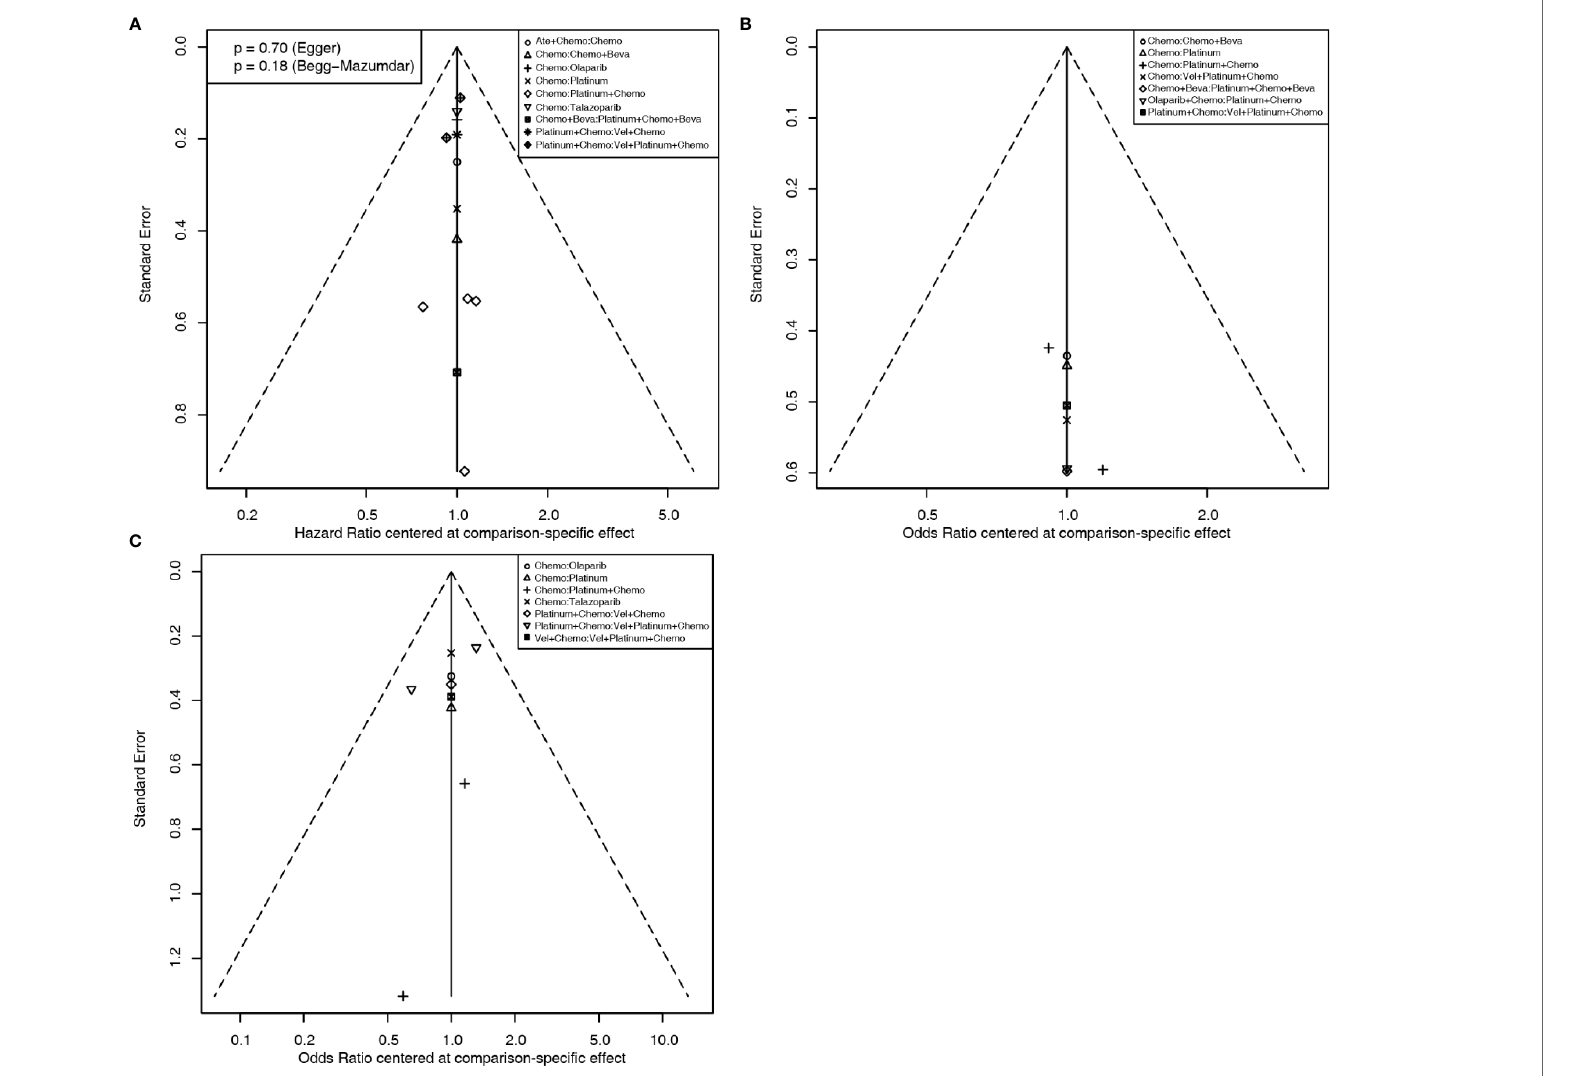
FIGURE 5 | Comparison-adjusted funnel plots for assessing PFS (A) , pCR (B) , and ORR (C) results. Potential publication bias is assessed by whether the data point distribution is symmetrical, and the Egger ’ s and Begg ’ s test results are calculated if the number of data point is more than